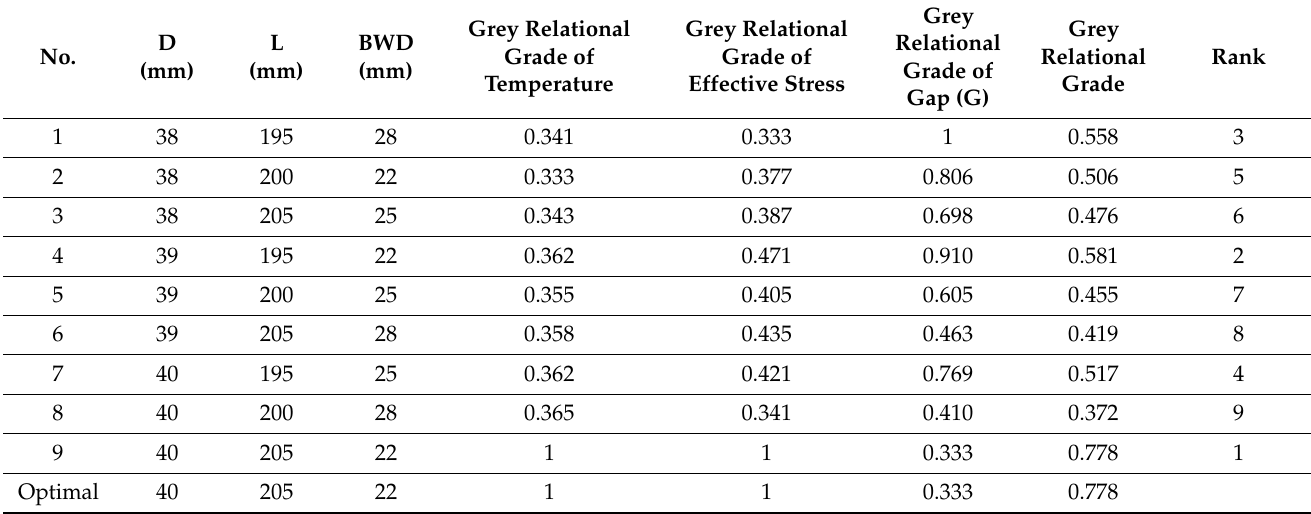
Table 11. Grey relational analysis for multiobjective optimization.